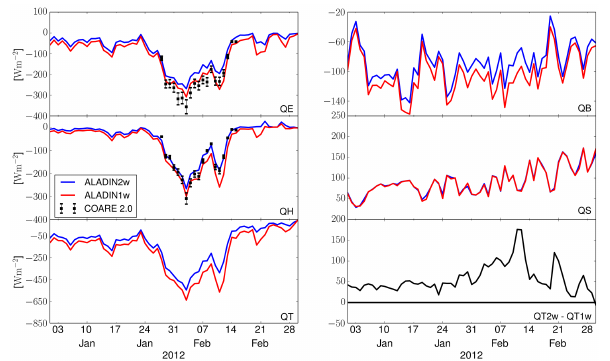
Figure 7. Same as Fig. 6 but for Paloma location.